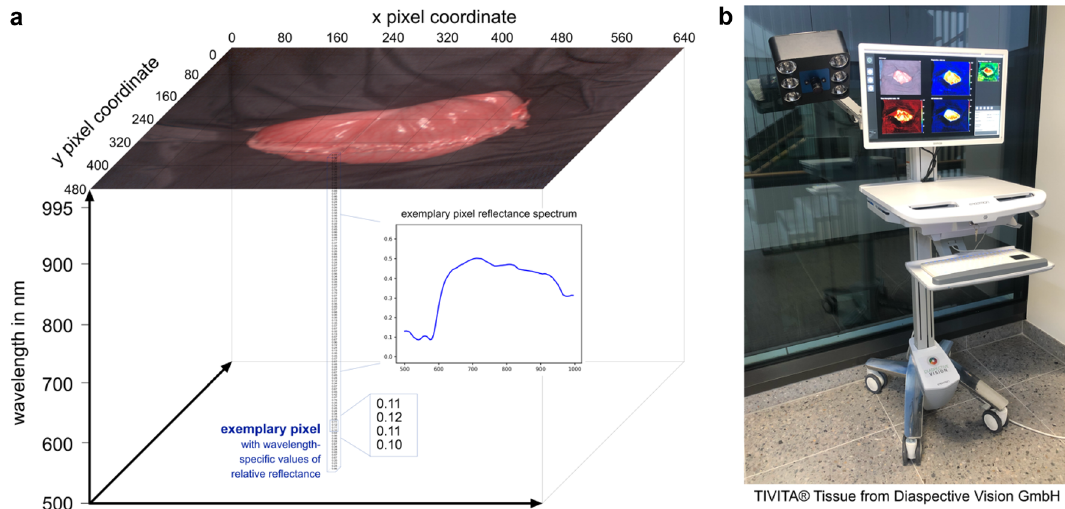
Figure 6. Hyperspectral camera system. ( a ) Visualization of a three-dimensional hyperspectral datacube with x and y as spatial dimensions and z as hyperspectral dimension. The recorded reflectance information content of one pixel is visualized as an example. ( b ) TIVITA® Tissue camera